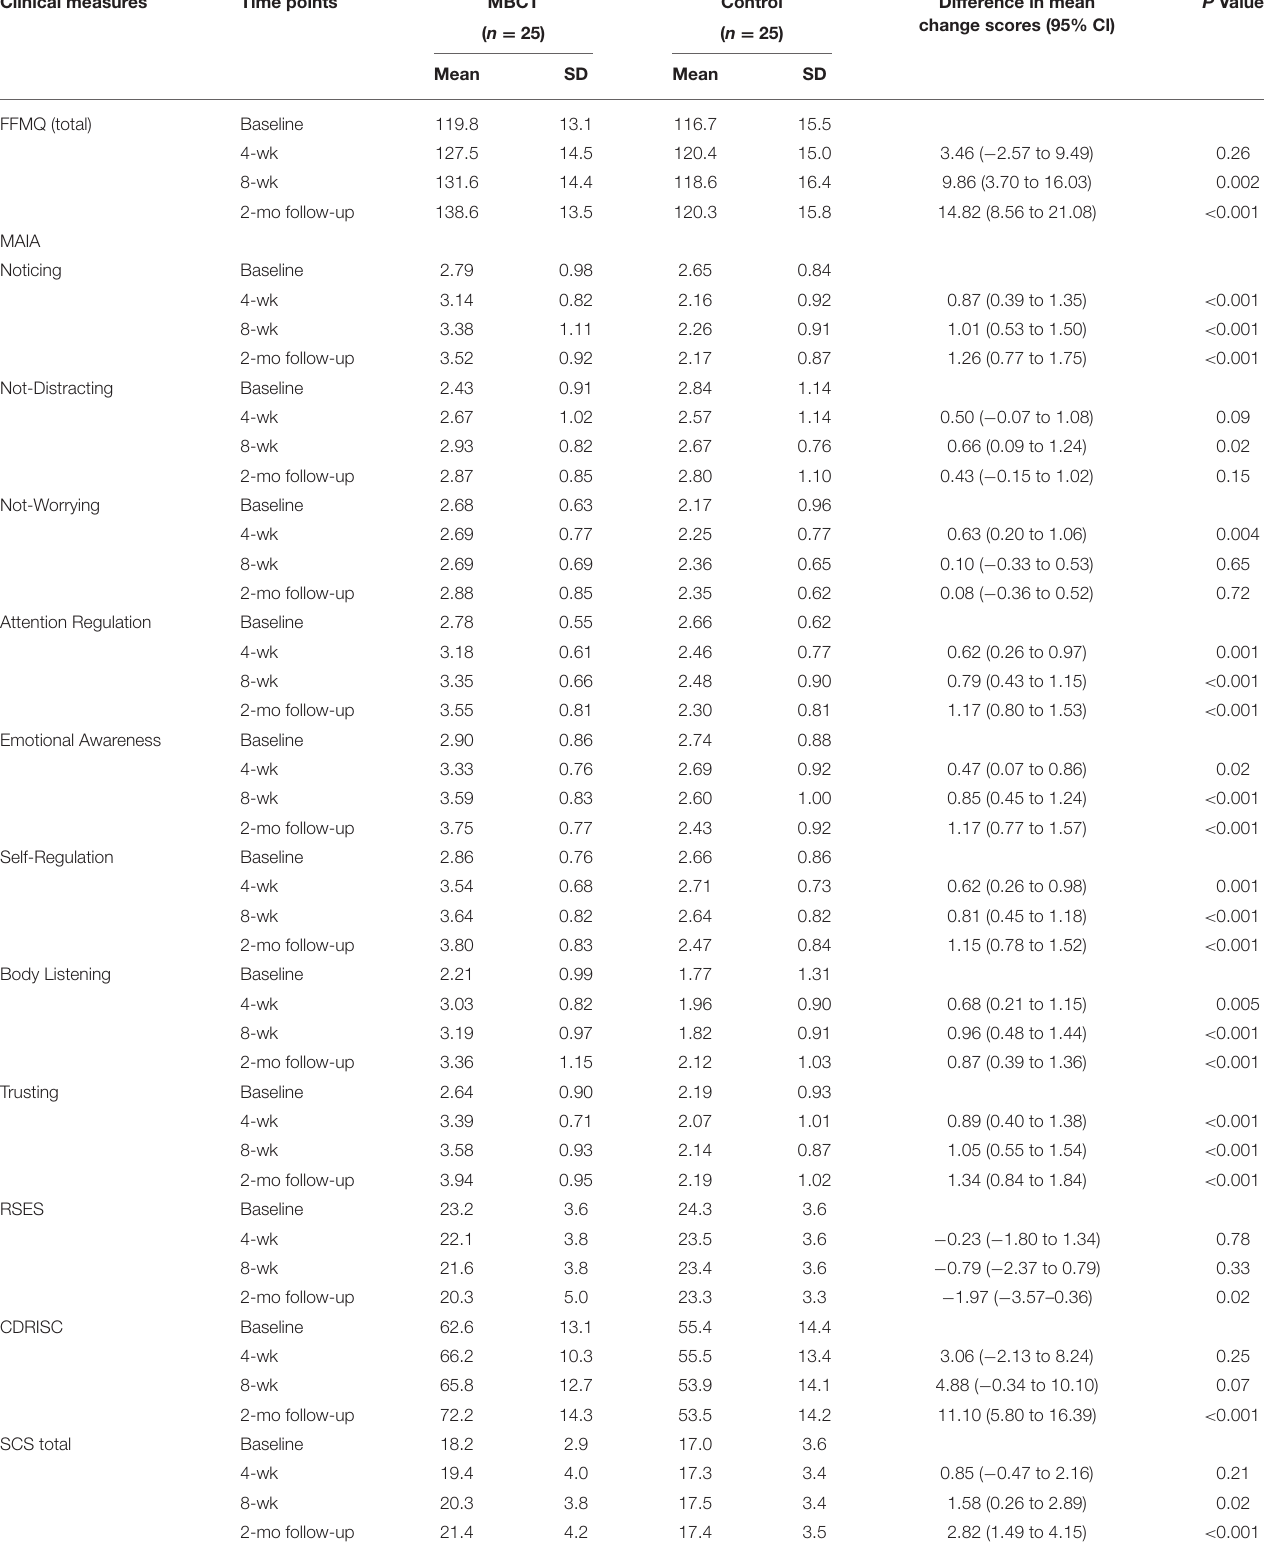
TABLE 7 | Summary of repeated-measure analyses of other outcomes (intention-to-treat population). Clinical